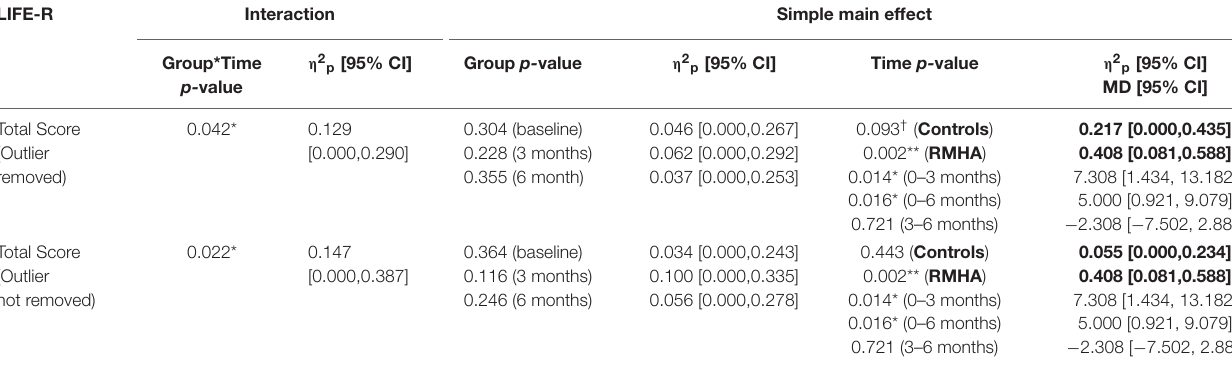
TABLE 5 | The p -values, partial eta squared ( η 2 p ) effect size, and CIs of the effect size, of the LIFE-R Total Score. LIFE-R Interaction Simple main